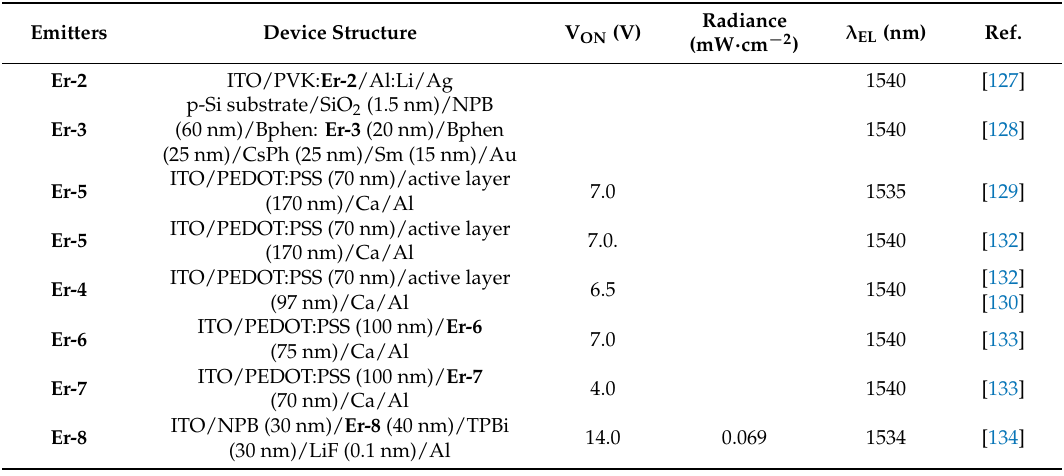
Table 5. Summary of electroluminescent properties of organic light-emitting diodes (OLEDs) fabricated with